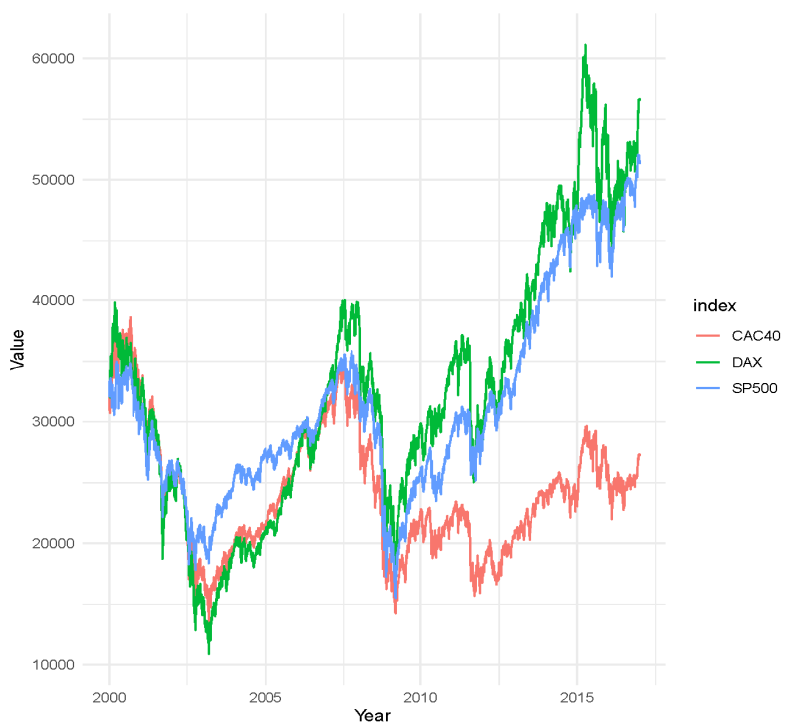
Figure 1. Investment evolution of the aggregate daily value of a portfolio that invests 100,000 units in the S&P 500 index, the DAX index, and the CAC 40. The investment is equally split into three components on 1 January 2000 and the investment goes on until 31 December 2016.